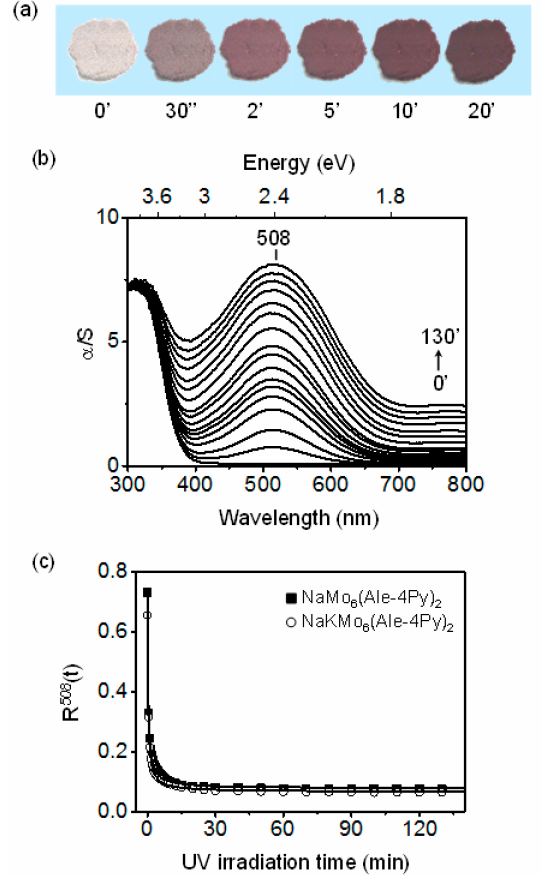
Figure 6. ( a ) Photographs of the powder of NaKMo 6 (Ale-4Py) 2 at different UV irradiation time (in min). ( b ) Evolution of the photo-generated absorption in NaKMo 6 (Ale-4Py) 2 after 0, 0.5, 1, 2, 3, 4, 5, 7, 10, 15, 20, 30, 40, 60, 80, 100 and 130 min of UV irradiation ( λ ex = 365 nm). ( c ) Comparison of the R 508 ( t ) vs. t plots for NaMo 6 (Ale-4Py) 2 (  ), and NaKMo 6 (Ale-4Py) 2 (  ). The lines show the fits of the plots according to rate law R 508 ( t ) = a/(b t + 1) + (R 508 ( 0 ) −